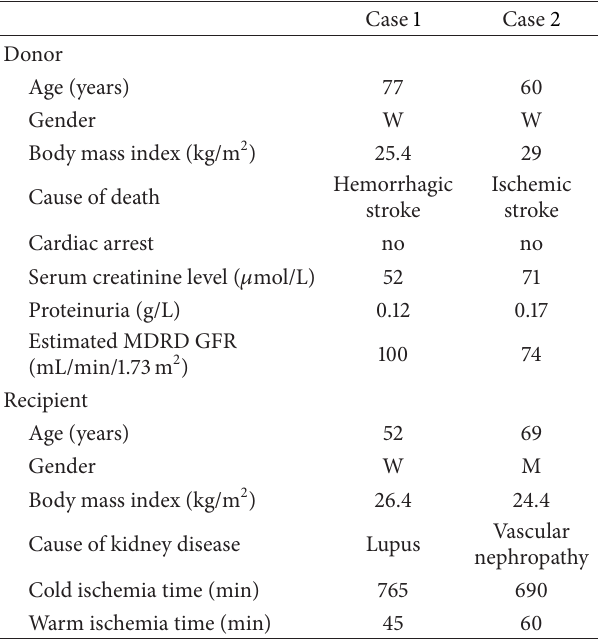
Table 1: Donors’ and recipients’